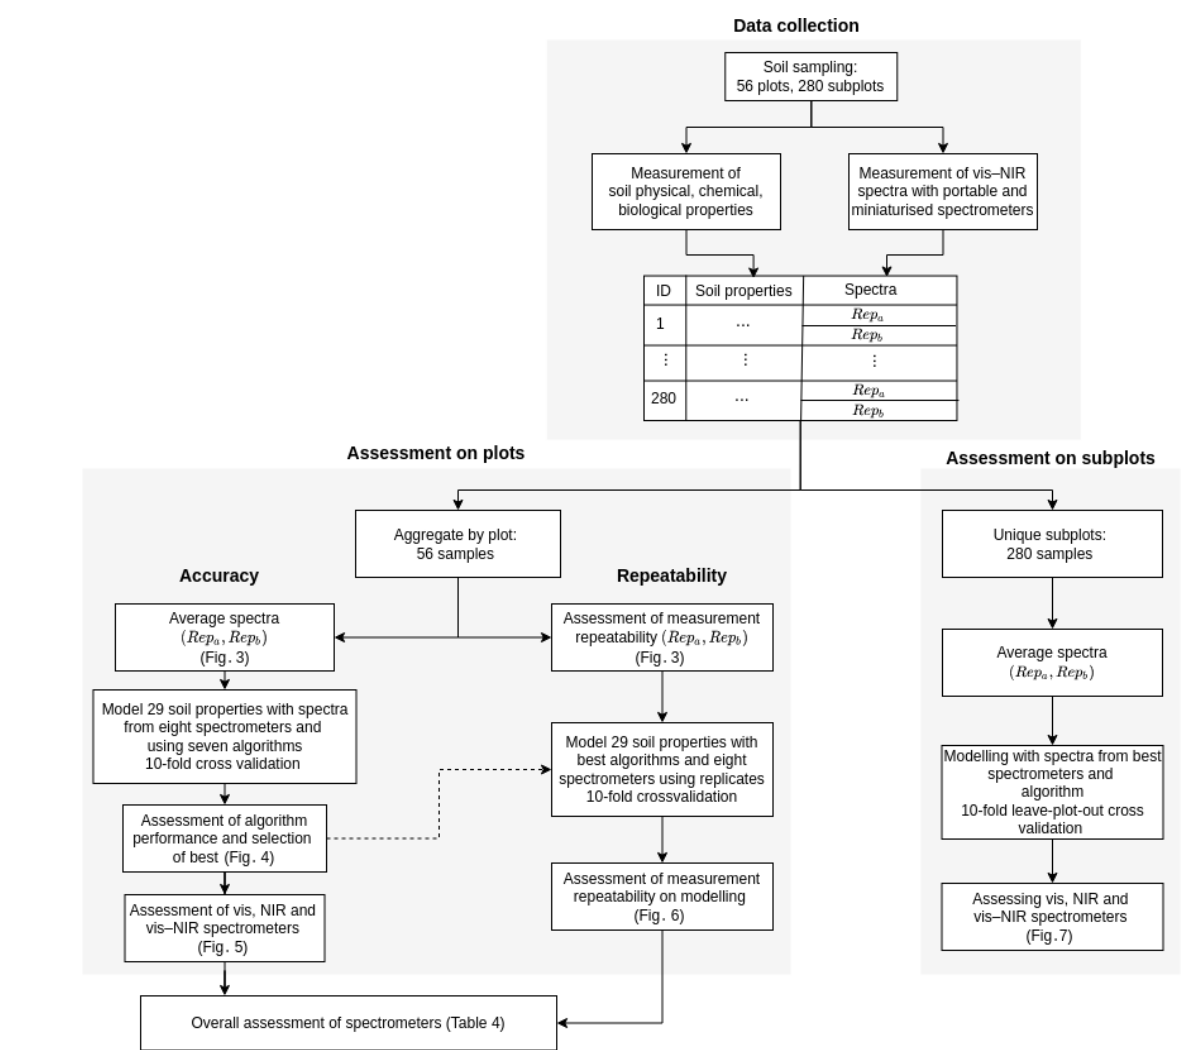
Figure 2. Study design for data collection and spectroscopic modelling. Data collection describes the measurement of soil properties and collection of spectra. Assessment on plots shows the spectroscopic modelling for the assessment of algorithms and spectrometers. Assessment on subplots validates the modelling with the best algorithm and spectrometers on subplot data.